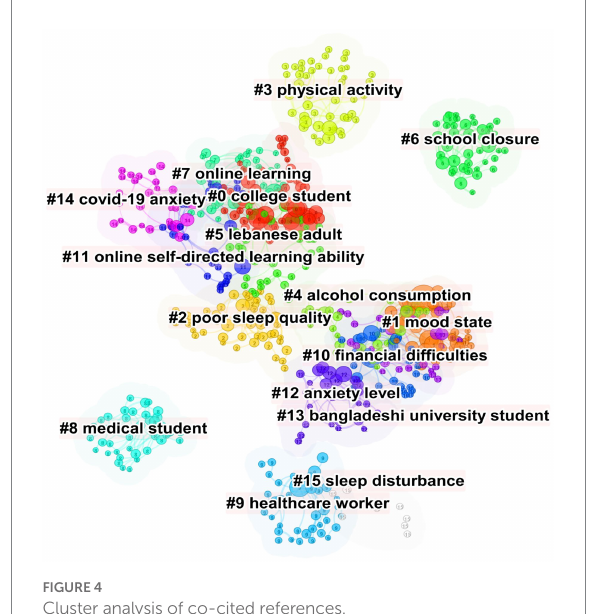
FIGURE 4 Cluster analysis of co-cited references.